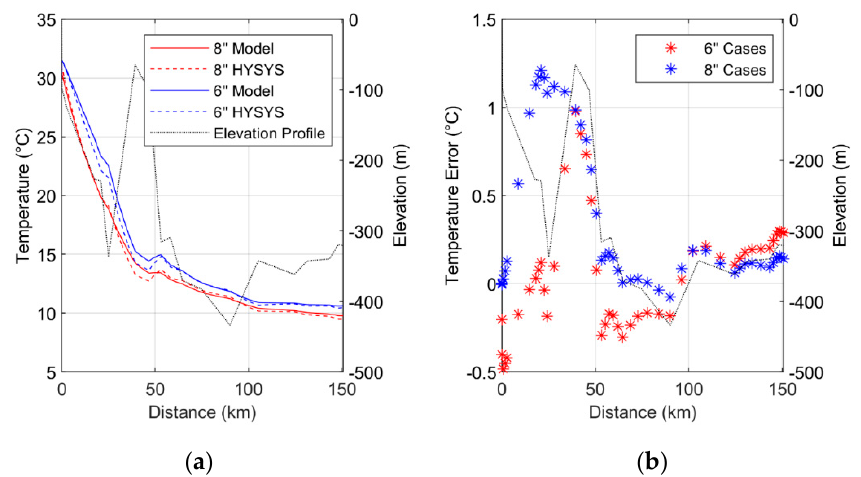
Figure 5. Comparison of Model and HYSYS Results for the Validation Case, ( a ) shows a Comparison of the Temperature Profile Results for the 10% Overpressure Case; and ( b ) shows the Absolute Temperature Difference Between the Results.